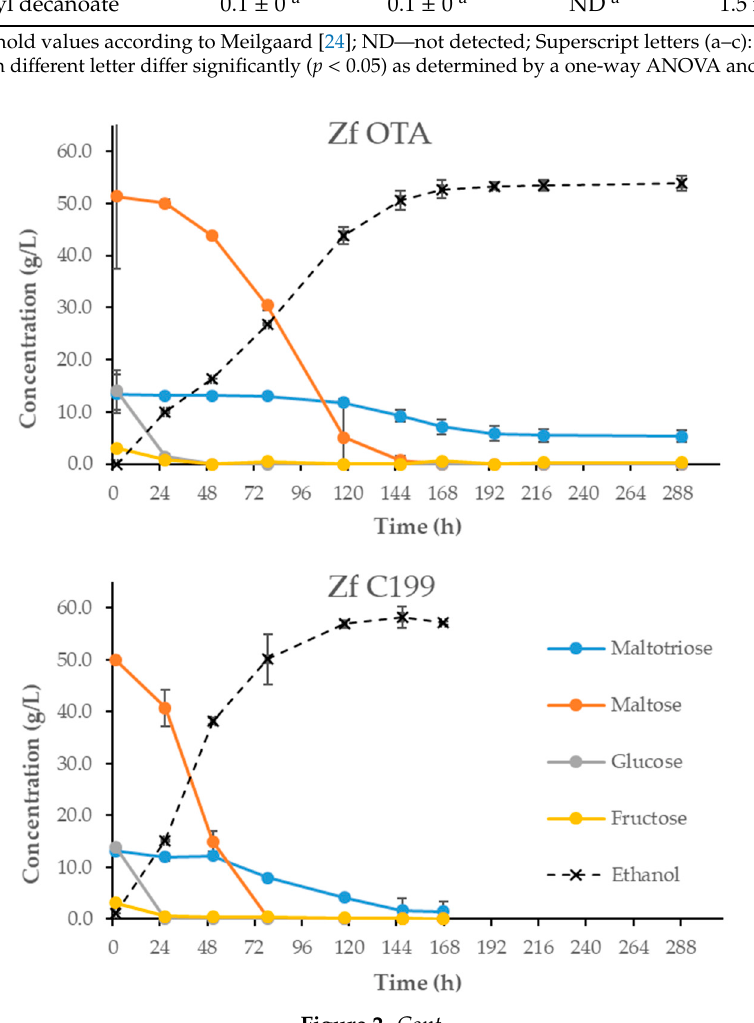
Figure 2. Consumption of individual sugars during the fermentation. The dotted line represents the progress of the fermentation with respect to the ethanol level. Values are the means from two independent fermentations. Error bars—when visible—represent the deviation between duplicates. The Finnish strain Z. flo OTA had higher values compared to the type strain Z. flo C199 for most of the volatile aroma compounds analyzed (Table 2). Although none of the values exceeded the indicative flavor threshold values [24], aroma levels were comparable to the levels of the reference ale strain A62. The Finnish isolate had three aroma values—ethyl acetate (fruity), 3-methylbutanol (banana) and 2-phenylethyl acetate (floral)—over the lower flavor impact values (i.e., the value that could be affecting the taste, although the compound itself is not recognized; definition: aroma level divided by threshold value > 0.5 [24]). The A62 strain had the lower impact values exceeded by four